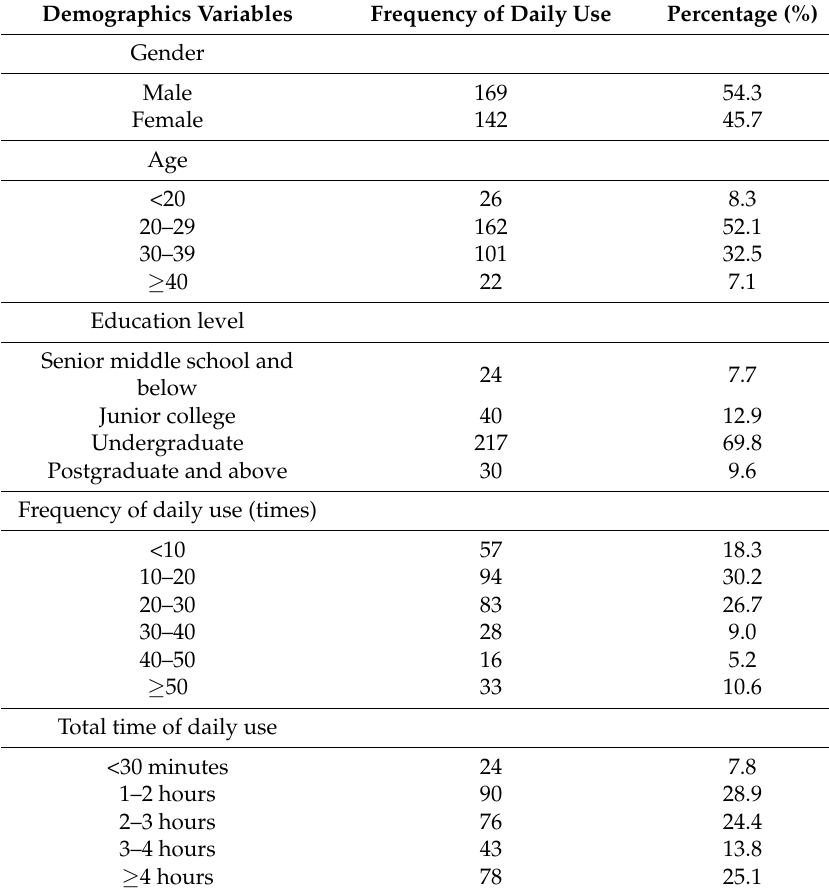
Table 2. Demographics analysis (The number of sample =